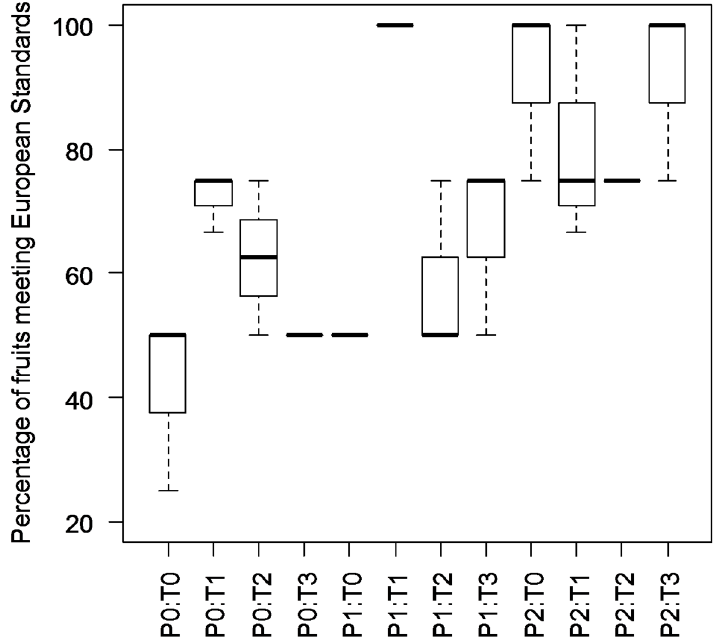
Figure 3. Effect of organo-mineral fertilizer on percentage of fruits meeting European standards. P0T0: 0 t ha − 1 of poultry litter and N-P-K in Kg ha − 1 100-30-150, P0T1: 0 t ha − 1 of poultry litter and N-P-K in Kg ha − 1 200-60-300, P0T2: 0 t ha − 1 of poultry litter and N-P-K in Kg ha − 1 400-120-600, P0T3: 0 t ha − 1 of poultry litter and N-P-K in Kg ha − 1 600-180-900, P1T0: 5 t ha − 1 of poultry litter and N-P-K in Kg ha − 1 100-30-150, P1T1: 5 t ha − 1 of poultry litter and N-P-K in Kg ha − 1 200-60-300, P1T2: 5 t ha − 1 of poultry litter and N-P-K in Kg ha − 1 400-120-600, P1T3: 5 t ha − 1 of poultry litter and N-P-K in Kg ha − 1 600-180-900, P2T0: 10 t ha − 1 of poultry litter and N-P-K in Kg ha − 1 100-30-150, P2T1: 10 t ha − 1 of poultry litter and N-P-K in Kg ha − 1 200-60-300, P2T2: 10 t ha − 1 of poultry litter and N-P-K in Kg ha − 1 400-120-600, P2T3: 10 t ha − 1 of poultry litter and N-P-K in Kg ha − 1 600-180-900.